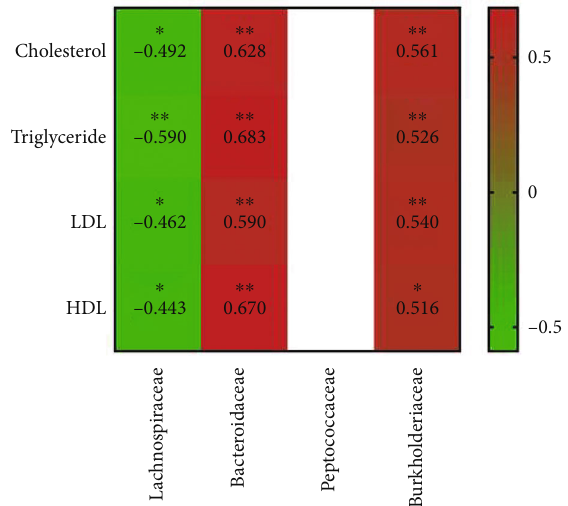
Figure 5: Correlation between microbiome and serum lipid content. Spearman ’ s correlations between fecal microbiome and levels of di ff erent serum lipids are shown. ∗ indicates P < 0 : 0 5 and ∗∗ indicates P < 0 : 01